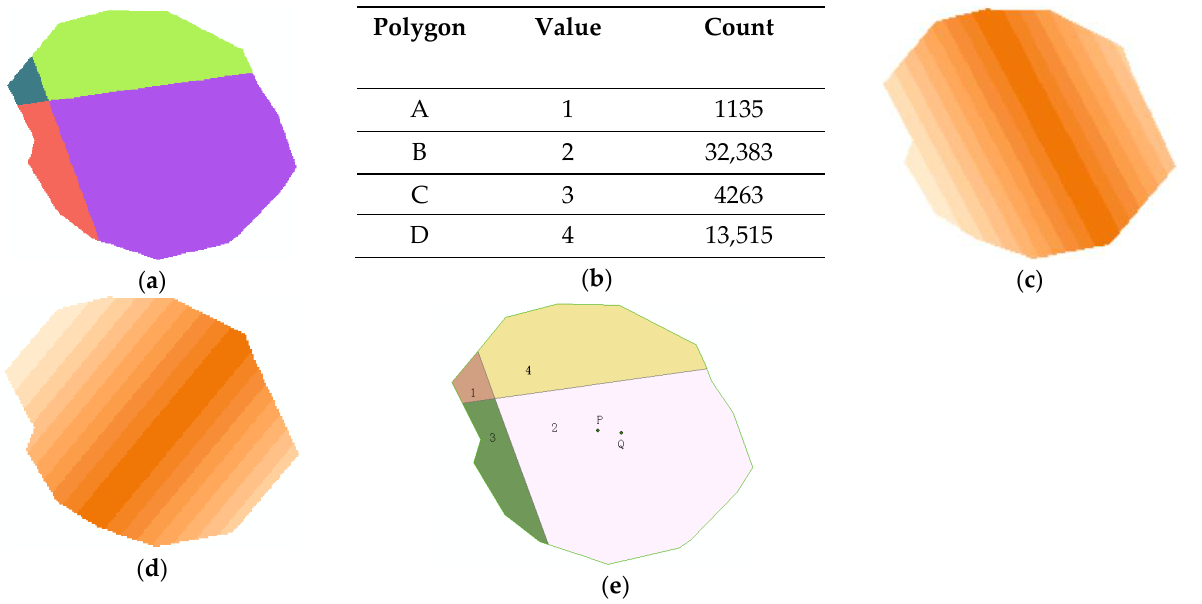
Figure 5 . Centroid computing of polygon S and the corresponding homogeneous polygon with the same boundary as polygon S : ( a ) raster dataset of polygon S ; ( b ) statistics of the raster grid numbers of polygon A , B , C , D ; ( c ) result of the Euclidean distance transformation of the first candidate centroid balance line; ( d ) result of the Euclidean distance transformation of the second candidate centroid balance line; ( e ) comparison of the final centroid of polygon S and the centroid of the corresponding homogeneous polygon .